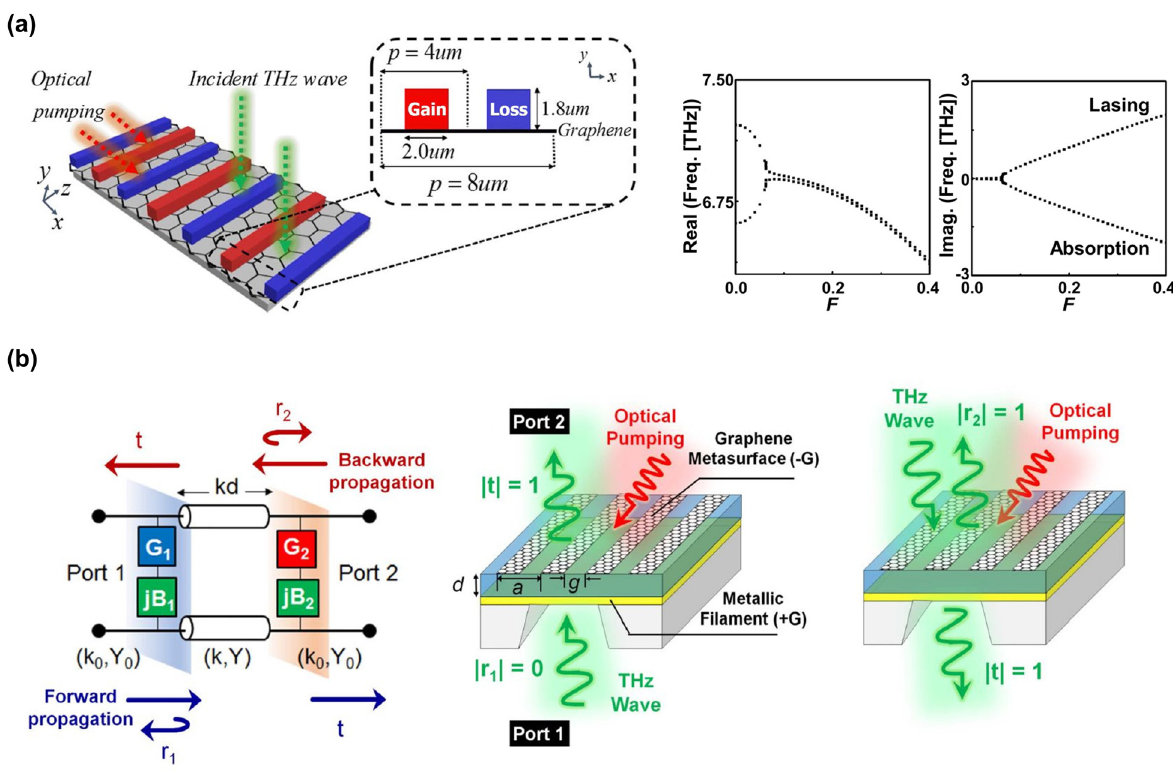
Figure 12: Proposed ideas for optically-pumped graphene-based PT systems controlling the unidirectionality of the THz radiation. (a) Monolayergrapheneand PT-diffraction grating compositemetasurface andcalculatedcomplex dispersion curvesof the eigenfrequencies ( k x =0)asafunctionofthenon-Hermiticitycoef fi cient F .Adaptedwithpermissionfromref.[53].Copyright2017,theAuthors,publishedbythe